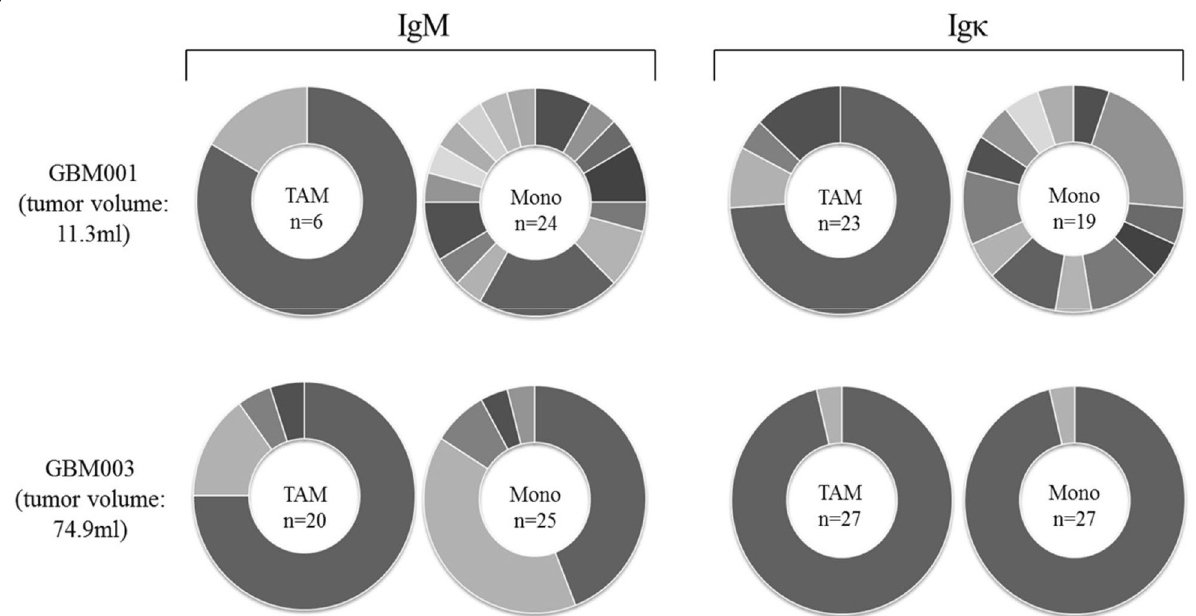
Fig. 2 TAM Ig heavy and light chain repertoires are less diverse than those of circulating monocytes. IgM and Igκ repertoire diversities in circulating monocytes and tumor macrophages from two representative patients (GBM001 and GBM003). Sector areas correspond to the relative frequency of individual clonotypes within a given Ig CDR3 repertoire and are sorted by size. Each sector within a circle chart represents a unique CDR3 variant and the total number of identified variants is shown in the center. Note that TAM express less diverse IgM and Igκ repertoires than monocytes from the same patients. The tumor volumes of the two patients are shown (11.3 ml and 74.9 mL, respectively). The repertoire diversities of all